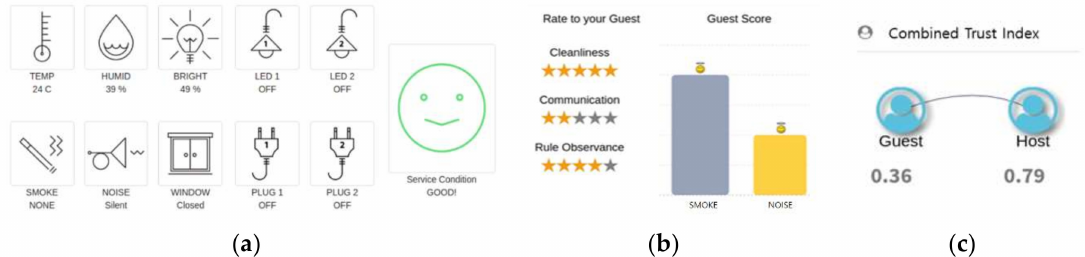
Figure 10. Trust analysis and evaluation at Trust BnB. ( a ) Objective trust analysis with IoT devices; ( b ) subjective trust evaluation; ( c ) trust